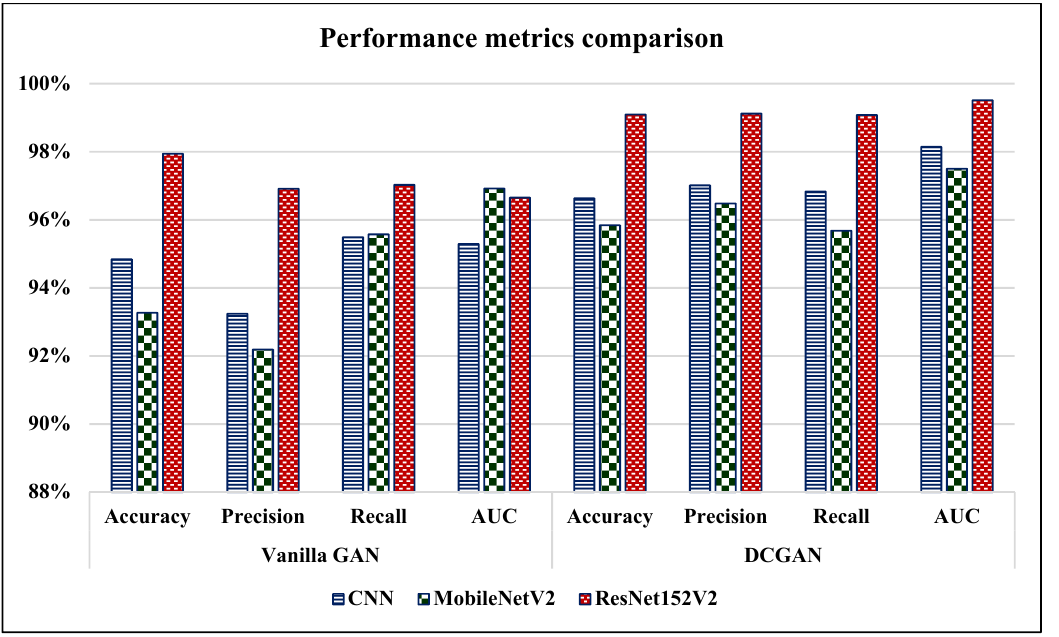
Figure 14. Loss measures for the CNN, MobileNetV2, ResNet152V2 models using Vanilla GAN and DCGAN image generated.